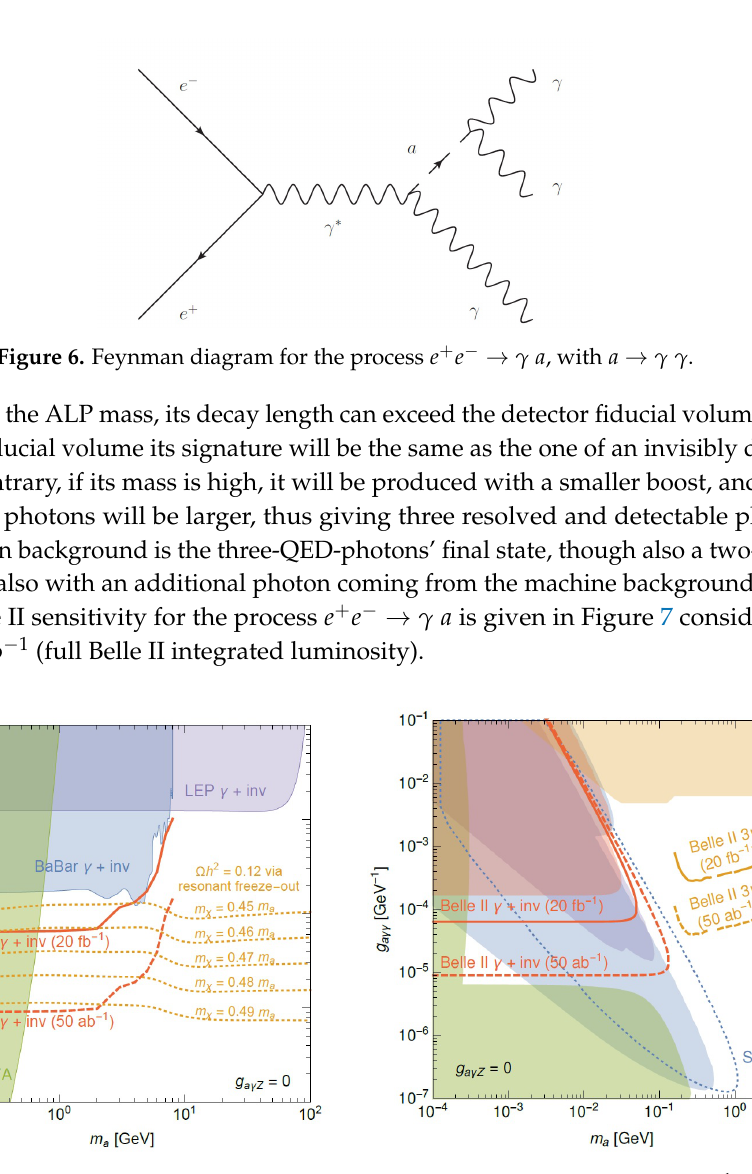
Figure 7. Expected upper limits (90% CL) on the g a γγ coupling constant for a 20 fb − 1 integrated luminosity (Phase 2) and for a 50 ab − 1 (Phase 3, full Belle II integrated